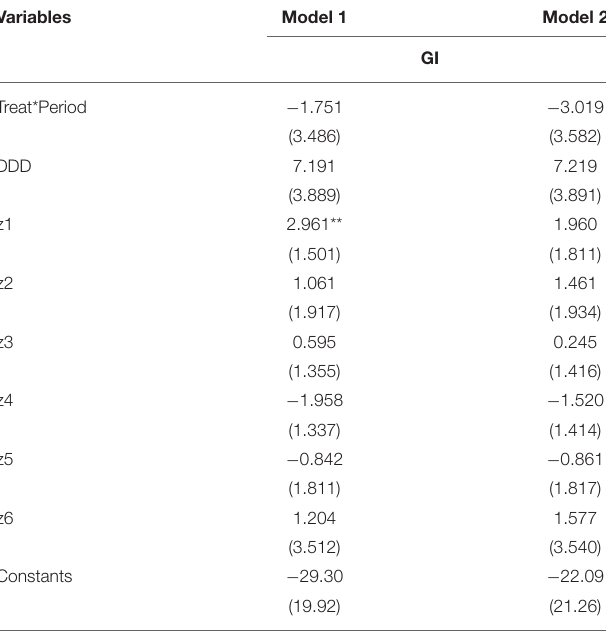
TABLE 8 | Robustness test adjusting the